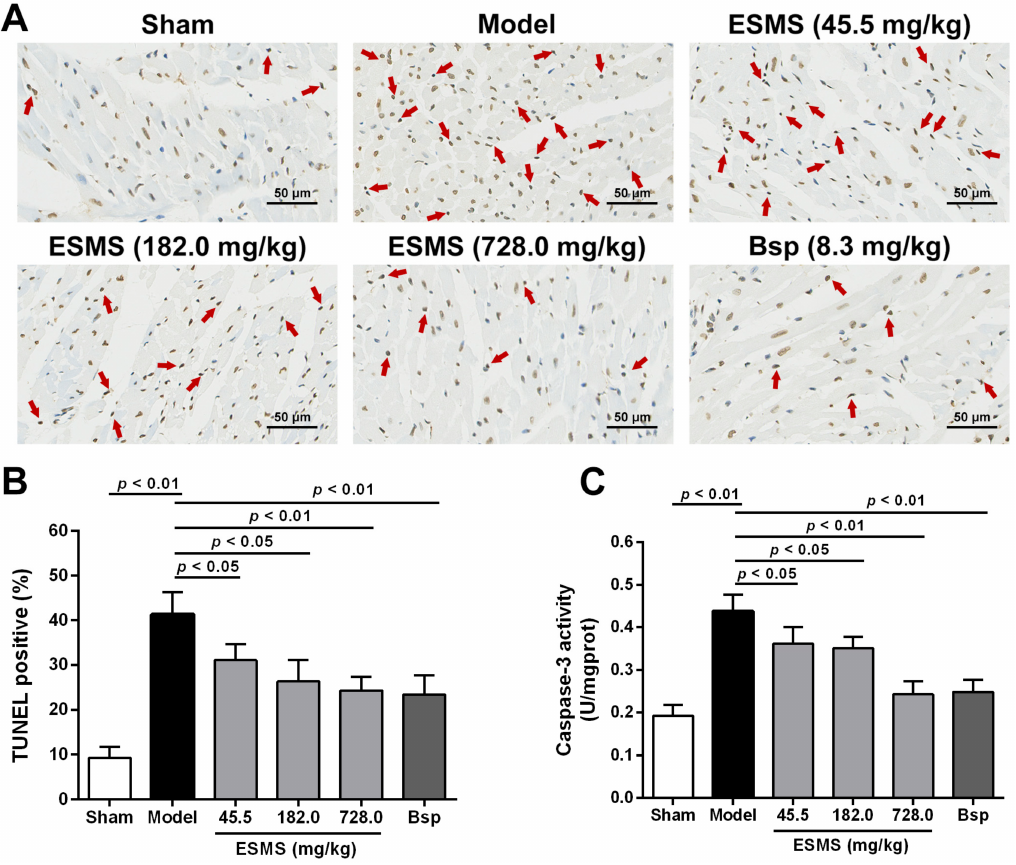
Figure 3. ESMS inhibited myocardial apoptosis in MI-induced HF mice. ( A ) Representative photomicrographs of terminal deoxynucleotidyl transferase-mediated deoxyuridine triphosphate nick-end labeling (TUNEL) staining images. The region of peri-infarcted was analyzed, and the arrow indicates apoptotic nuclei. Bar is 50 µ m; ( B ) Quantitative analysis of apoptotic cells in TUNEL staining ( n = 6); ( C ) Caspase-3 activity of all groups were determined in tissue after three weeks of CAL in mice ( n = 8). Results were presented as mean ± SD. Bsp = Bisoprolol (positive